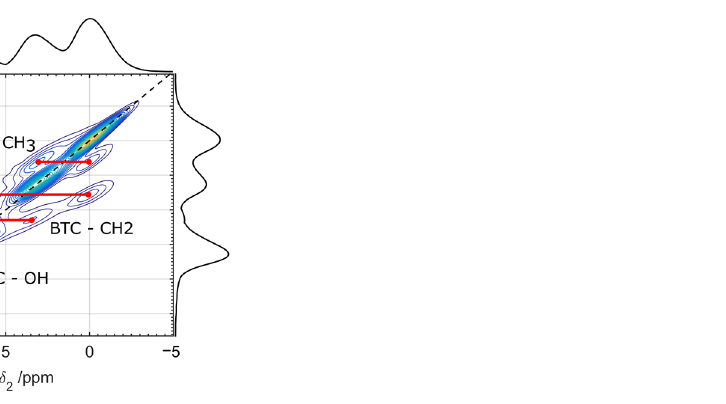
Figure 7. 2D 1H DQ-SQ correlation spectrum for [(Eu 2 Zr)(btc) 3 (Hbtc) 0.5 · 6H 2 O)] measured under 60 kHz MAS using R 14 5 symmetry-based homonuclear recoupling and no homonuclear decoupling 4 during DQ evolution. The red lines indicate the presence of 1 H- 1 H correlations.